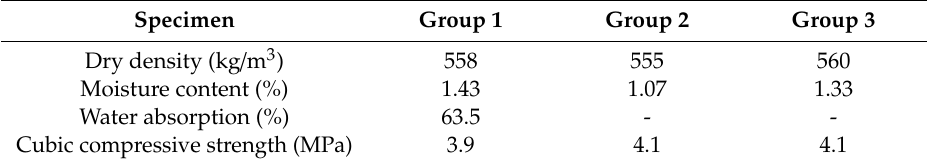
Table 2. Test results of fundamental properties of AAC self-insulation blocks.